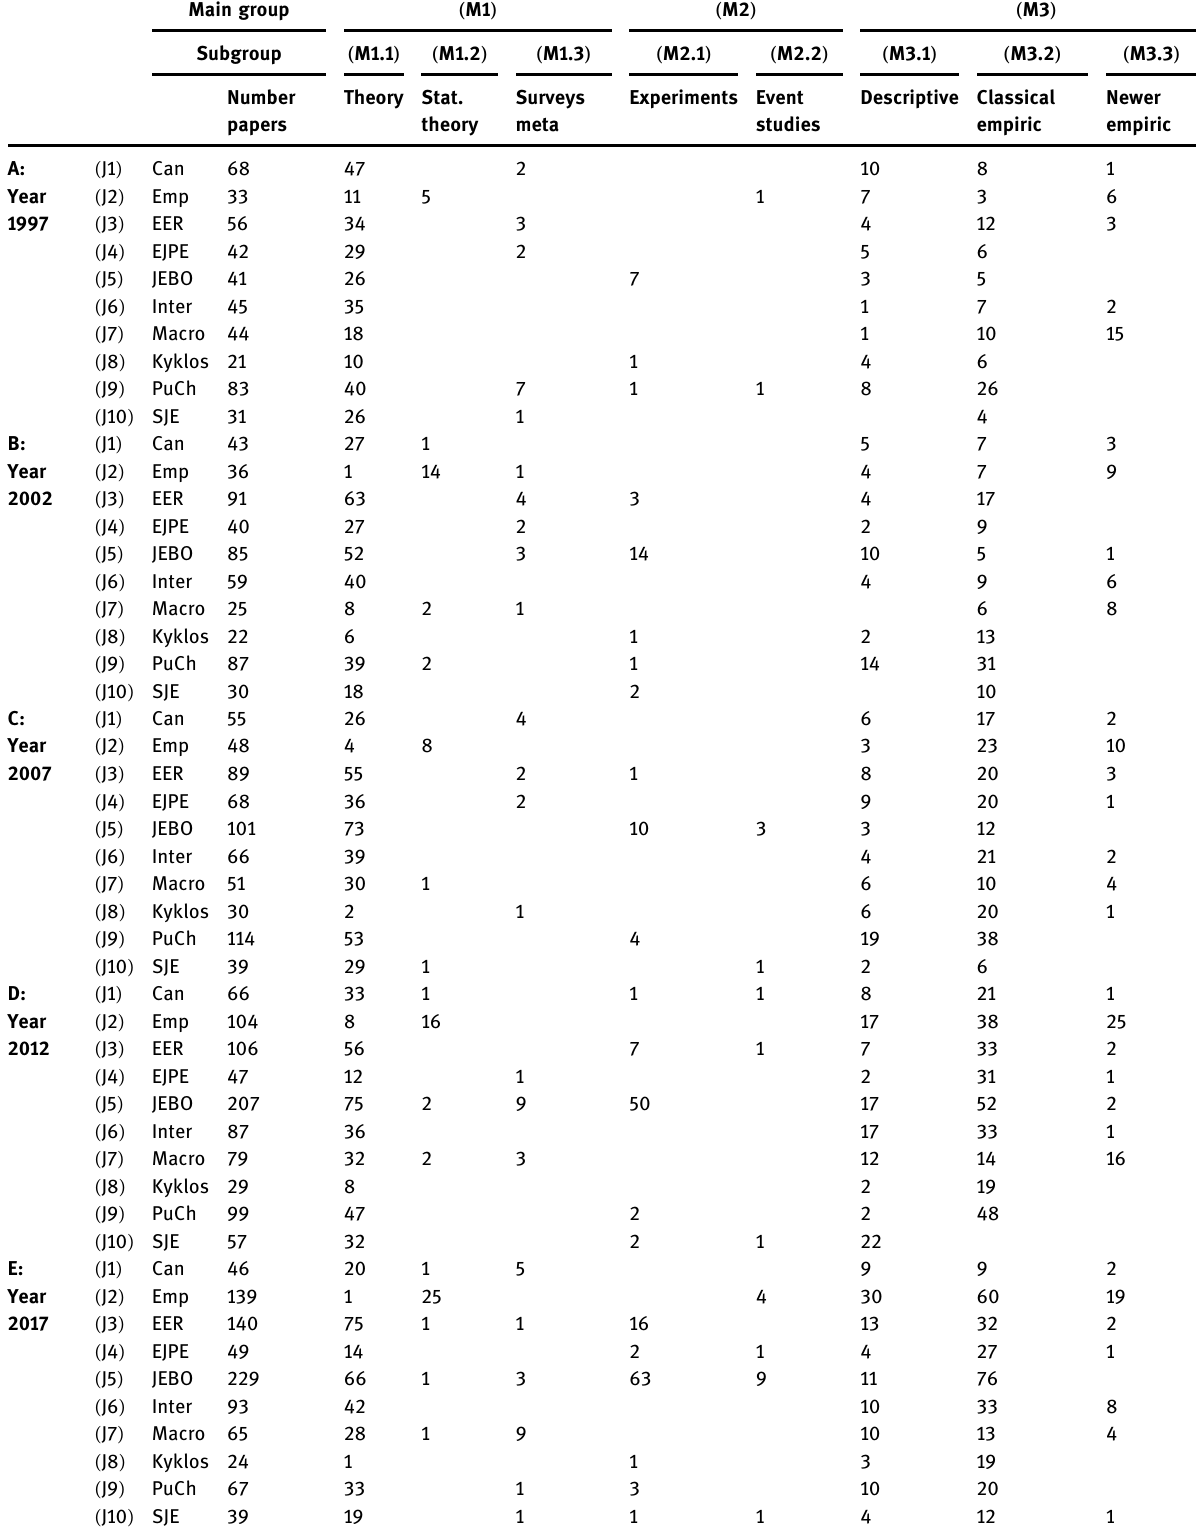
Table A1: The counts for each of the 10 journals Main